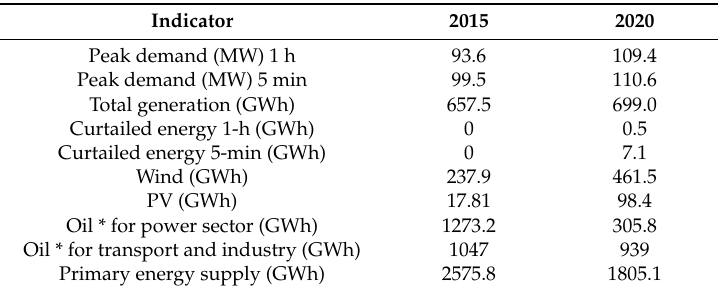
Table 5. Technical indicators of the energy system.